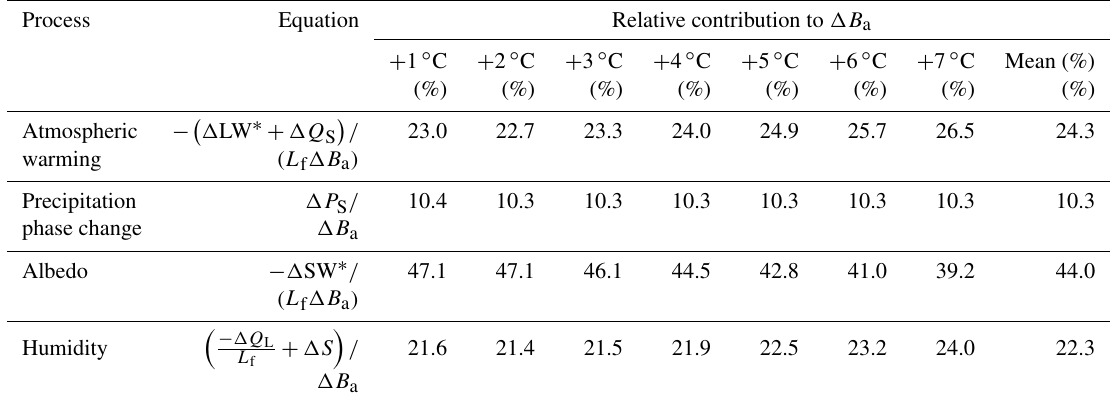
Table 1. Contribution of different processes to the sensitivity of glacier mass balance to warming from + 1 to + 7 ◦ C. Process Equation